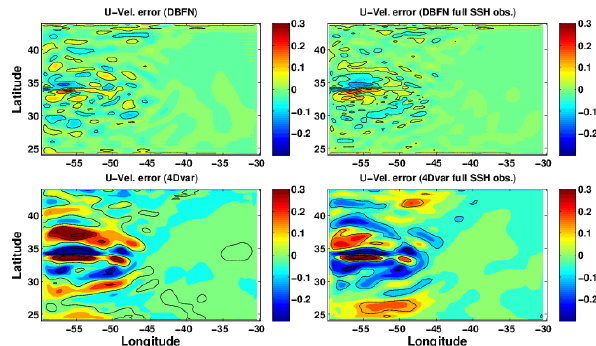
Figure 14. Zonal velocity error (analysis–truth) for the first assim- ilation cycle from DBFN experiments (top panels) and 4Dvar ex- periments (bottom panels). Right panels show the results obtained by assimilating complete daily fields of SSH and the left panels the results from the experiments presented in Sect.